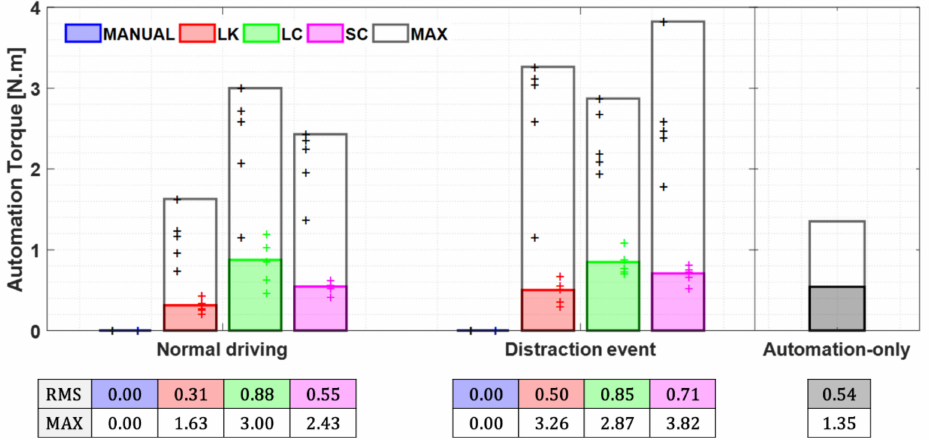
Figure 14. Driving efforts statistics (RMS and MAX of automation’s